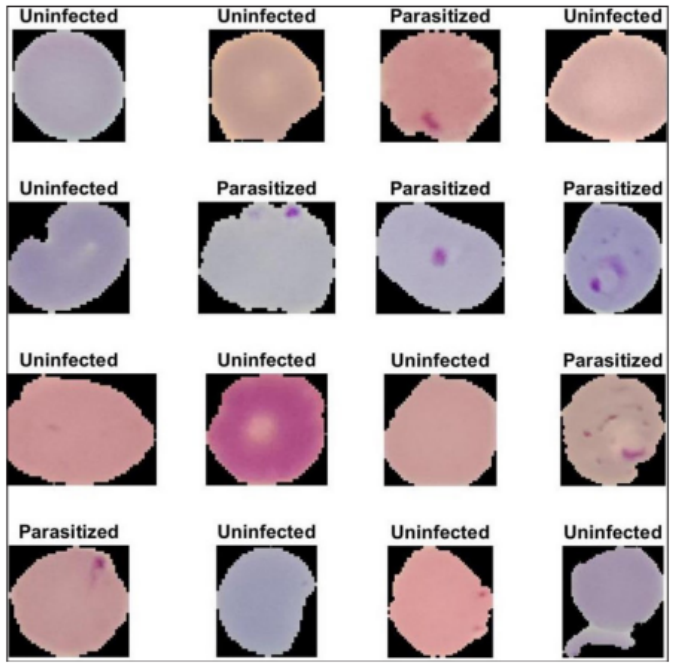
Figure 4. Sample of uninfected and infected cell